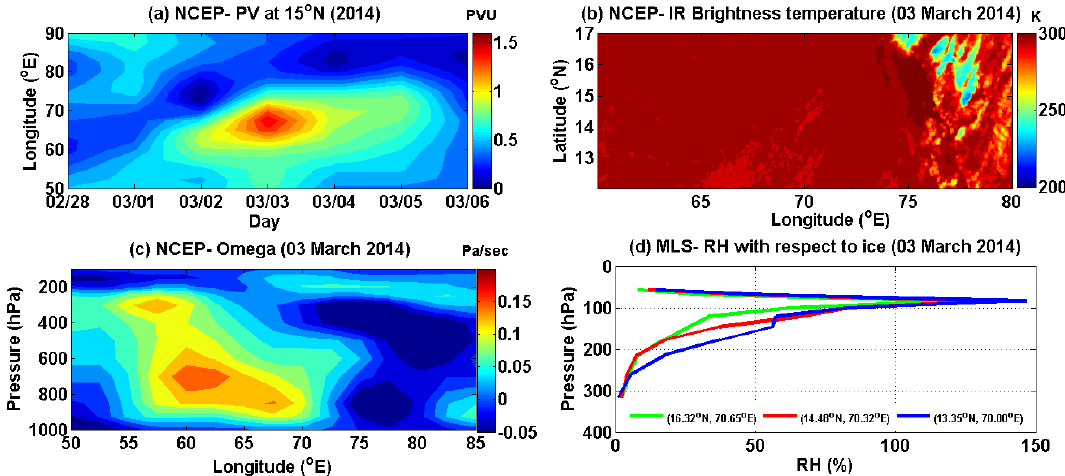
Figure 3. (a) Longitude–time cross section of PV (PVU) at 250hPa over 15 ◦ N from 28 February to 6 March 2014, (b, c) longitude–latitude cross sections of (b) brightness temperature (K) at 15 ◦ N, (c) omega (vertical pressure velocity) (Pa/s) at 15 ◦ N on 3 March 2014, (d) height profiles of RH_ice over the locations 16.32 ◦ N, 70.65 ◦ E; 14.48 ◦ N, 70.32 ◦ E; and 13.35 ◦ N, 70.00 ◦ E on 3 March